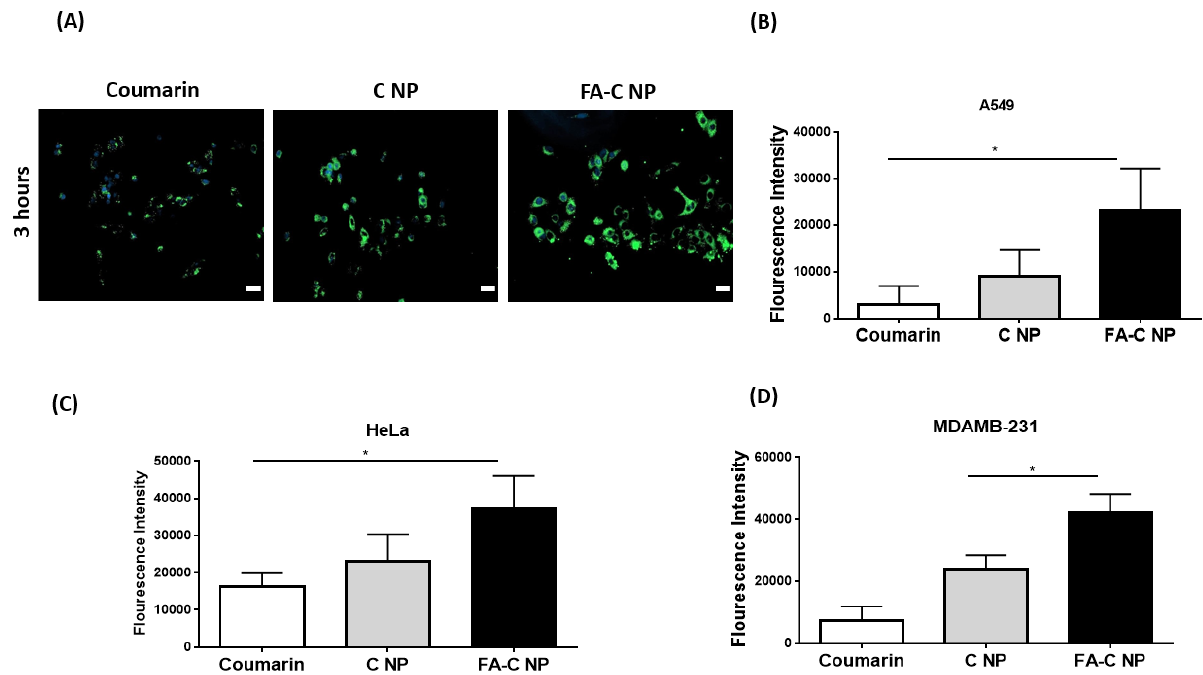
Figure 5. Intracellular uptake of coumarin-6-loaded nanoparticles (plain and FA-targeted). ( A ) Flu- orescence microscopy images in A549 at 3 h. Nuclei are stained blue (DAPI), and C NP and FA-C- NP are green. Scale bar = 100 μm. Representative images from n = 3 experiments. Scale bar =